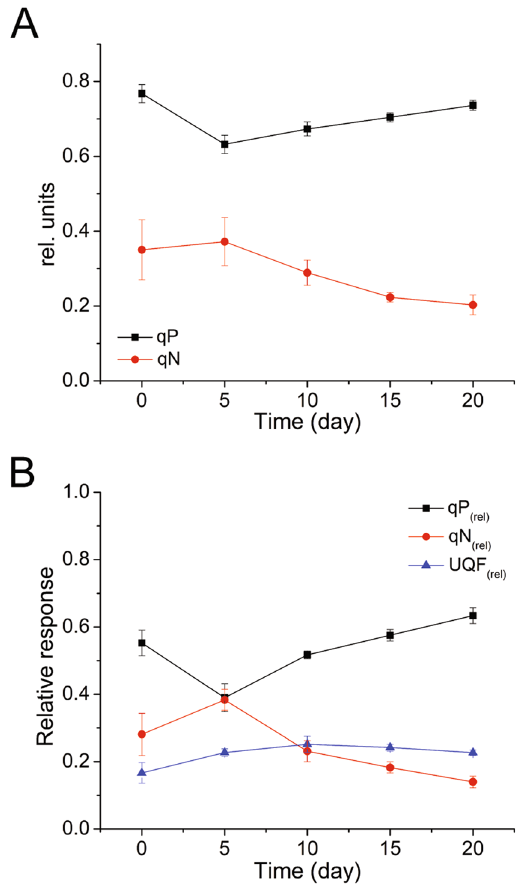
Figure 2. Distribution of energy dissipation of nitrogen-starved P. cruentum . ( A ) variation in the photochemical quenching coefficient (qP) and the non-photochemical quenching coefficient (qN) after nitrogen deficiency. ( B ) relative distribution of the dissipation energy processes through PSII of nitrogen- starved cells (qP (rel) , qN (rel) and UQF (rel)